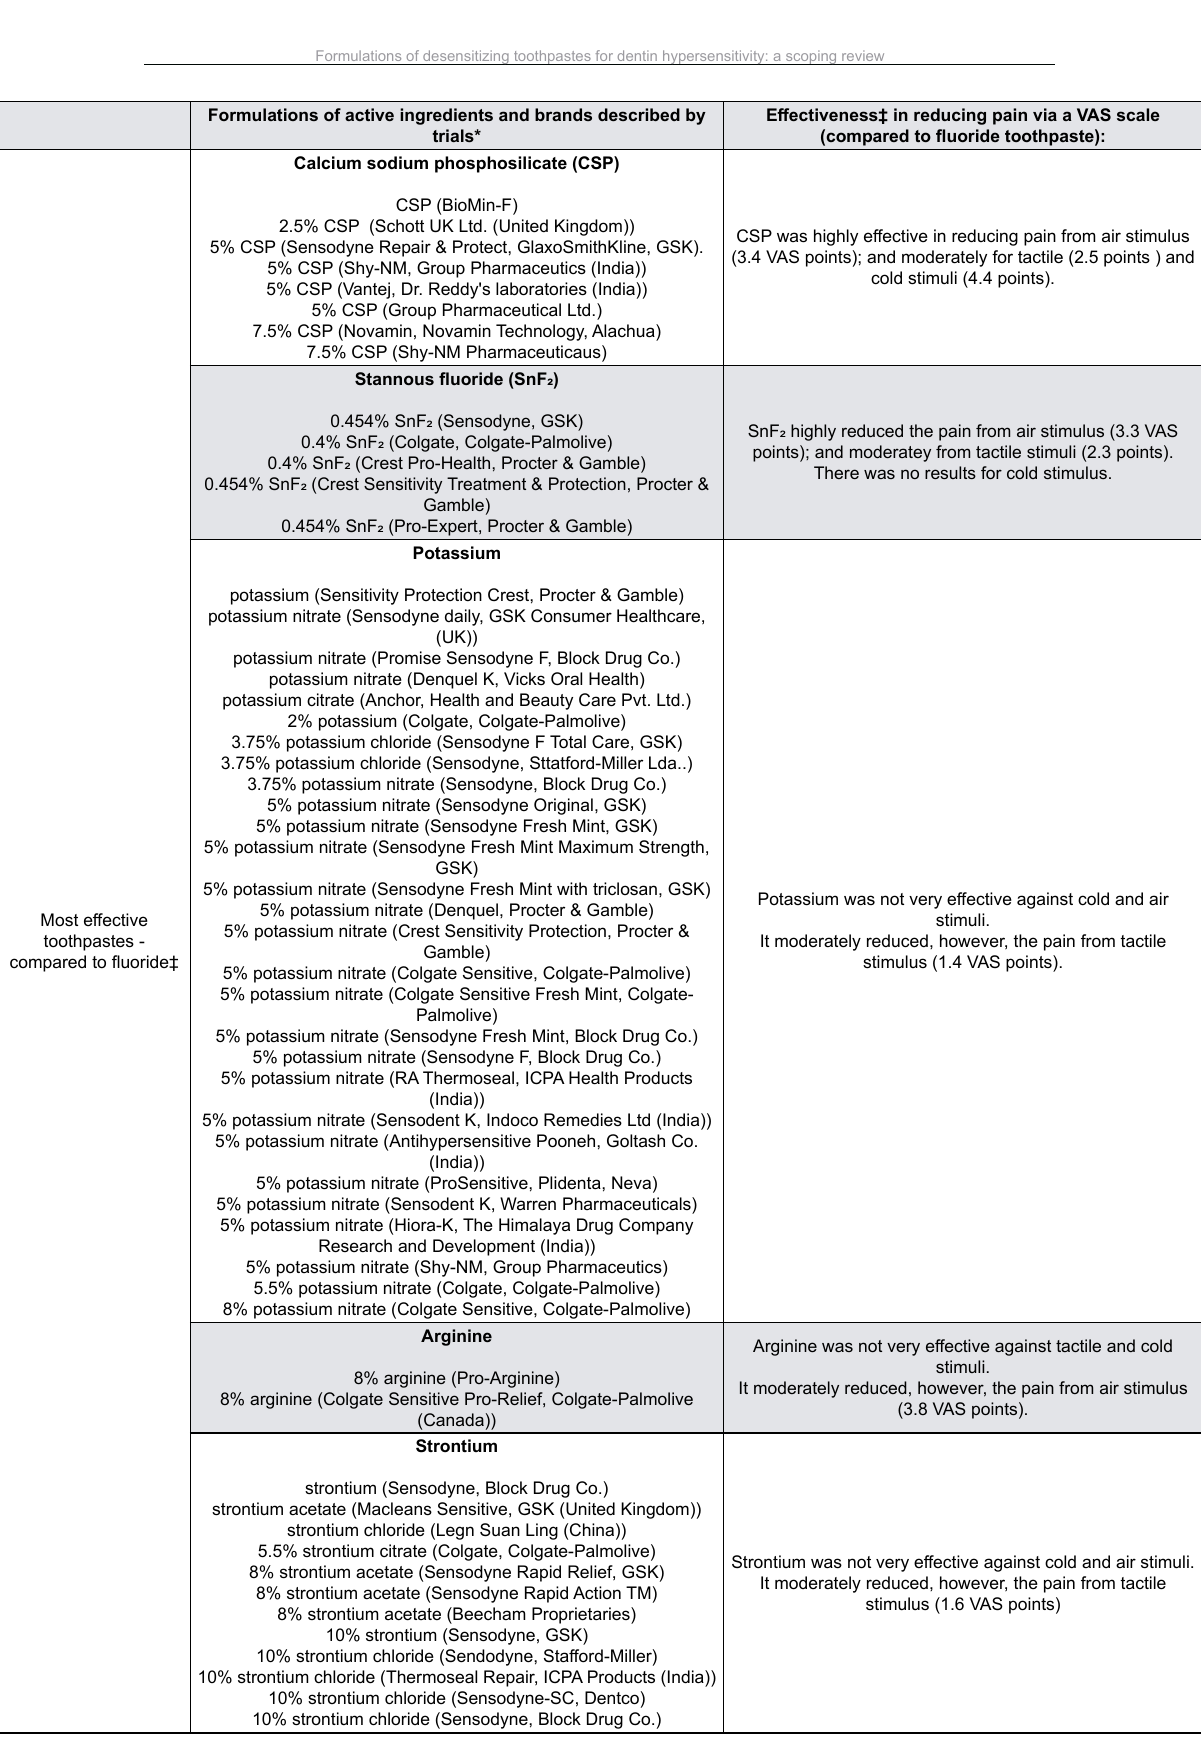
Figure 3- Description of the formulations of desensitizing toothpastes according to their effectiveness reported by